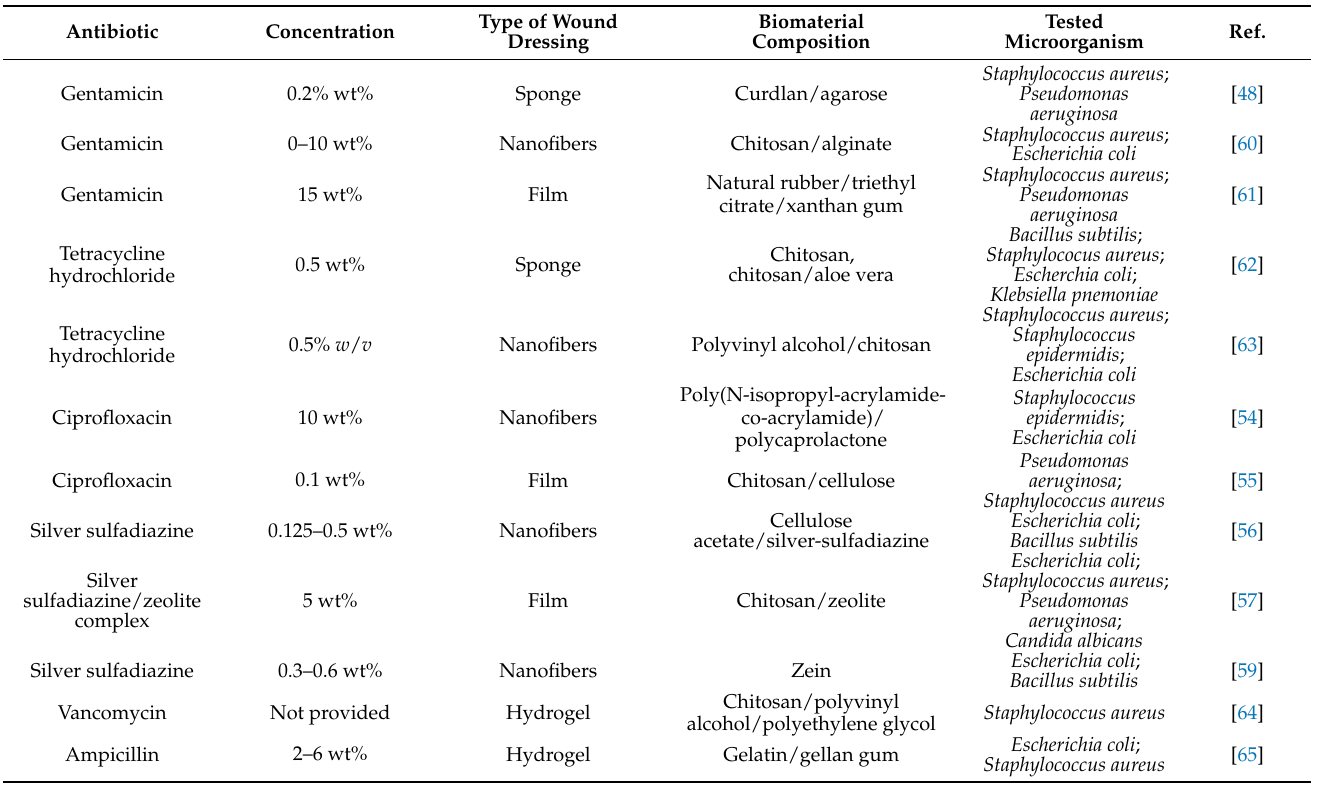
Table 2. Antibiotic-loaded biomaterials for wound healing